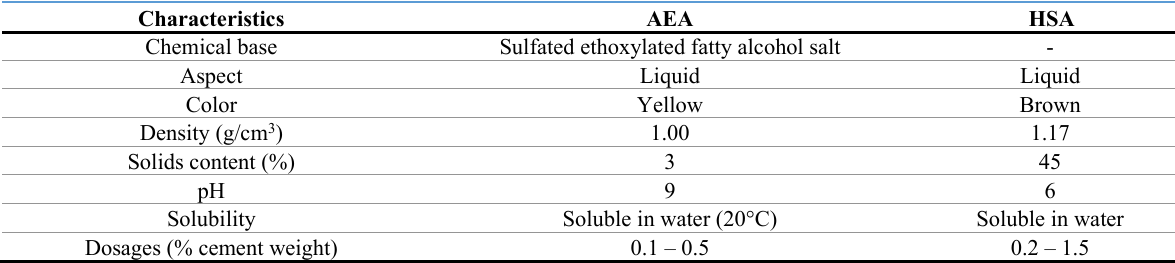
Table 4. Technical data of the air-entrained admixture (AEA) and hydration stabilizing admixture (HSA).